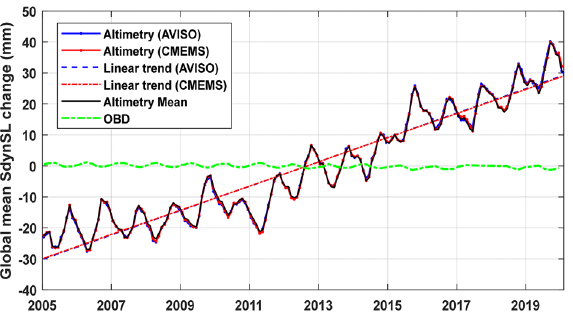
Figure 2. The global mean sterodynamic sea-level change series over January 2005 to December 2019 with two Altimetry products.